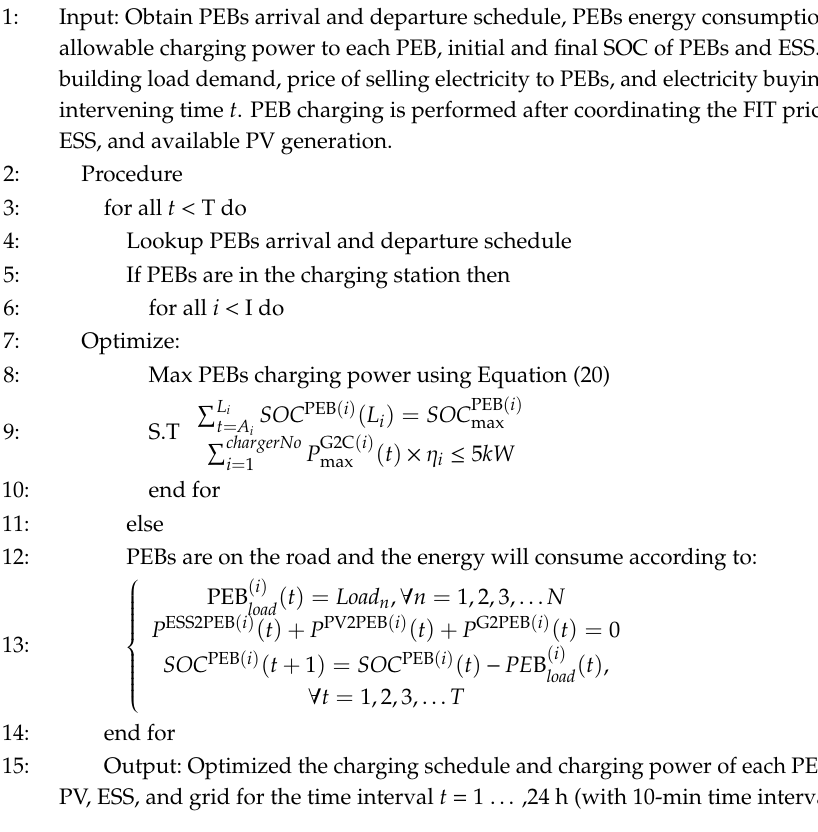
Algorithm 1 Coordinated with limited PEB charging power and charge scheduling algorithm.